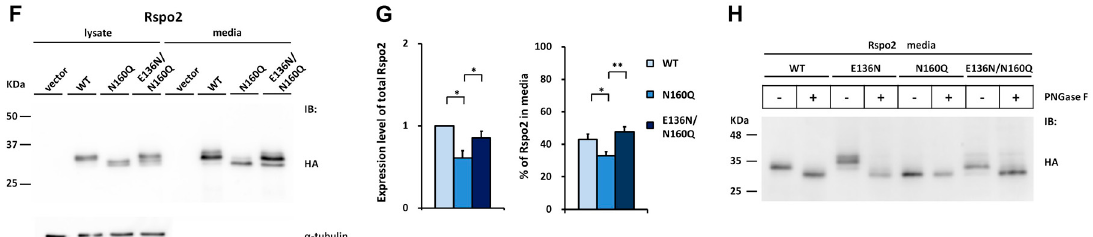
Figure 5. Effect of the engineered glycosylation site on glycosylation and secretion of human Rspo2. ( A ) Cell lysates or conditioned media from control vector or HA-tagged human Rspo2-transfected HEK293T cells were analyzed for the expression of HA-tagged human Rspo2 and the soluble β -catenin, * denotes non-specific bands; ( B , D , F ) WT Rspo2 or the indicated mutant was transfected into HEK293T cells. After 24 ( B ) or 48 h ( B , D , F ), the cell lysates and conditioned media were analyzed for HA-tagged Rspo2; ( C , E , G ) Quantification of total expression levels and percentage of Rspo2 in media for WT Rspo2 versus the indicated mutants are shown. Immunoblots were quantified densitometrically and relative expression level of Rspo2 in media or lysate was calculated. Error bars represent the mean ± SD. All experiments were performed in triplicate; ( H ) PNGase F digestion of WT, E136N, N160Q, and E136N/N160Q Rspo2 mutant. The Student’s t -test was used to evaluate statistical significance (* p < 0.05; ** p < 0.01). α -tubulin was used as a loading control for the cell lysates in each blot.